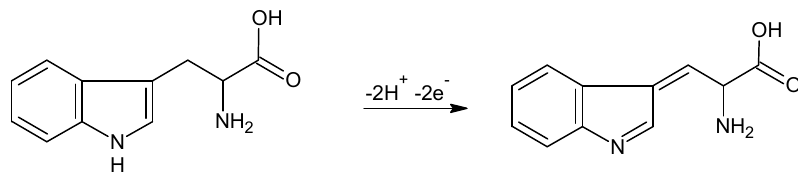
Figure 6. Process of the electrochemical oxidation of L-TRP (adapted from [35]).